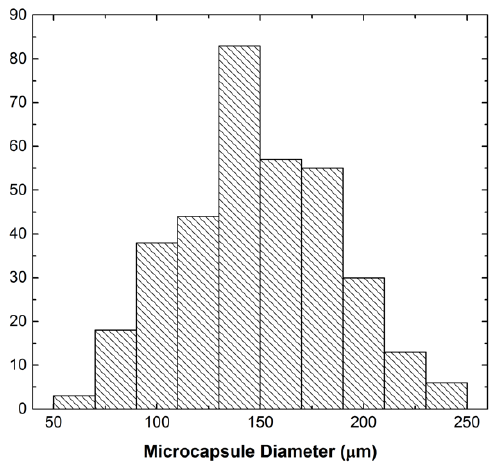
Figure 2. SEM Images of ( a ) dried microcapsules and ( b ) crack interface of resin with 20 wt% microcapsule content. Samples were sputter coated with platinum.